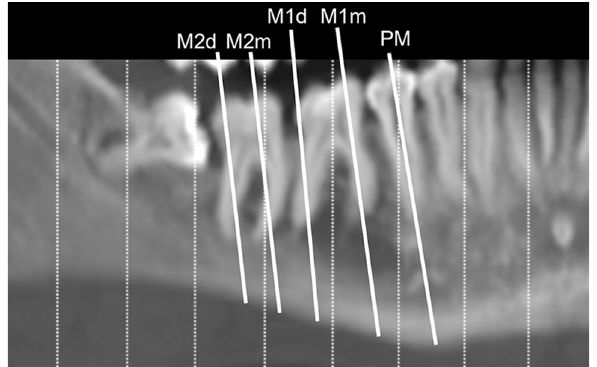
Figure 1. Schematic view on a panoramic image of the images selected on a level with the second premolar, and the mesial and distal roots of the first and second molars (sites PM, M1m, M1d, M2m and M2d, respectively).